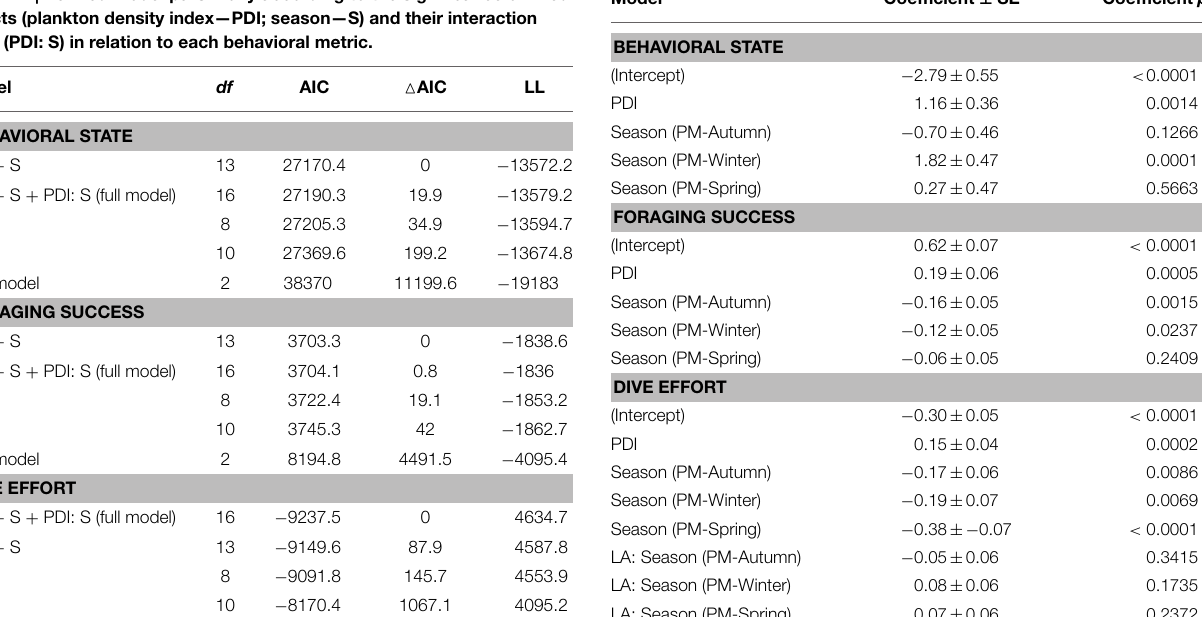
Term coefficients are presented ± SE and p-values for each coefficient are also shown. Significant terms (p < 0.05) are denoted by italic characters. Season variable was coded as a factor in the model, thus coefficients for the 3 post-molting periods (PM- Autumn, PM-Winter, PM-Spring) are given in reference to the post-breeding summer period